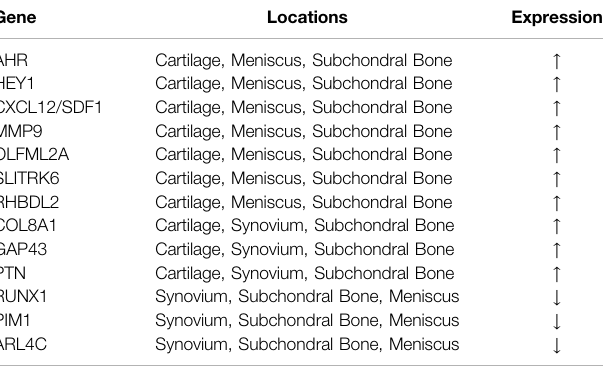
TABLE 2 | List of the most overlapping DEGs in OA joint